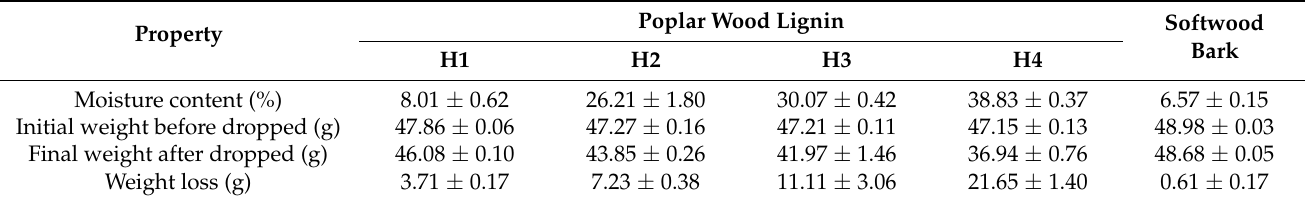
Table 3. Average weight loss for pellets following the impact resistance test (pellets were dropped from a 2.0 m height onto a concrete floor) for scenario